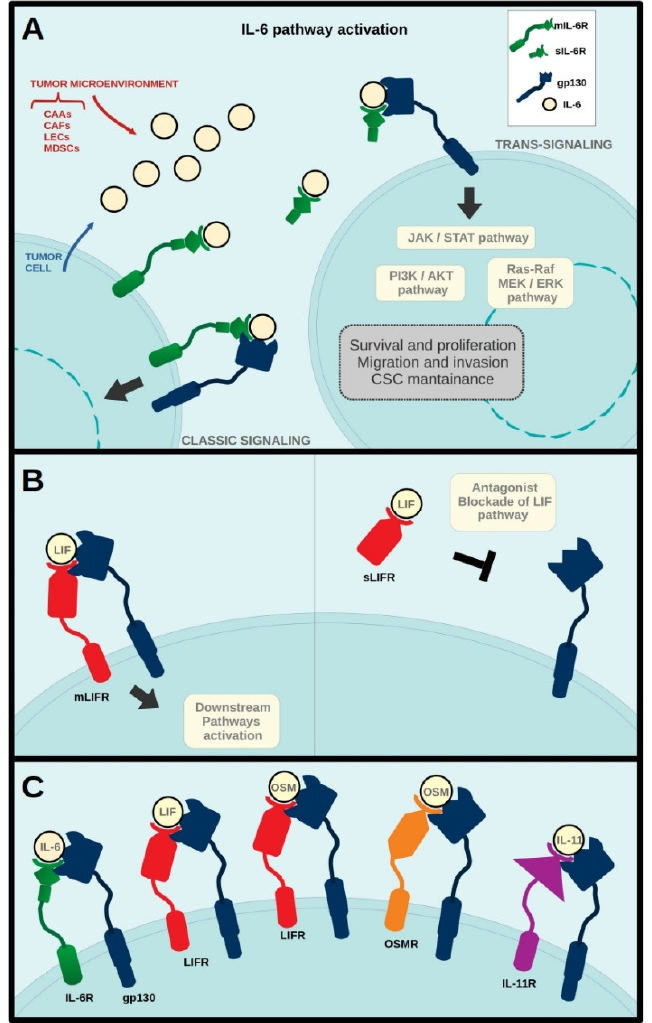
Figure 1. IL-6 cytokine pathway activation in breast cancer cells. IL-6 is secreted by tumor and stroma cells, such as cancer associated adipocytes (CAAs), cancer associated fibroblasts (CAFs), lymphatic endothelial cells (LECs), and myeloid derived stem cells (MDSCs). IL-6 binds to either transmembrane (mIL-6R) or soluble (sIL-6R) IL-6 receptor and to gp130 inducing ‘classic signaling’ through mIL-6R or ‘trans-signaling’ through sIL-6R ( A ). LIF binds to transmembrane LIF receptor (mLIFR) and gp130 inducing downstream signaling. LIF binding to soluble LIF receptors (sLIFR) blocks interaction with gp130 inhibiting LIF pathway activation ( B ). At the surface of target cells, secreted IL-6 cytokine family members bind to their specific receptors and gp130 to activate intracellular signaling cascades ( C